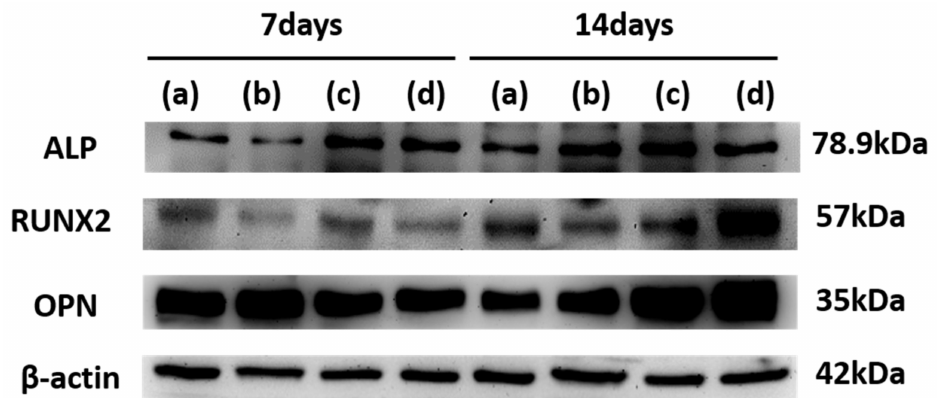
Figure 13. Western blot analysis of (a) PCL, (b) PCL/ β -TCP, (c) PCL/ β -TCP treated AA plasma, (d) PCL/ β -TCP treated DACH plasma. The expression of RUNX2, ALP and OPN proteins were determined by Western blot analysis after osteogenic differentiation for 7 and 14 days. Runx2, Runt-related transcription factor 2; ALP, Alkaline phosphatase; OPN,